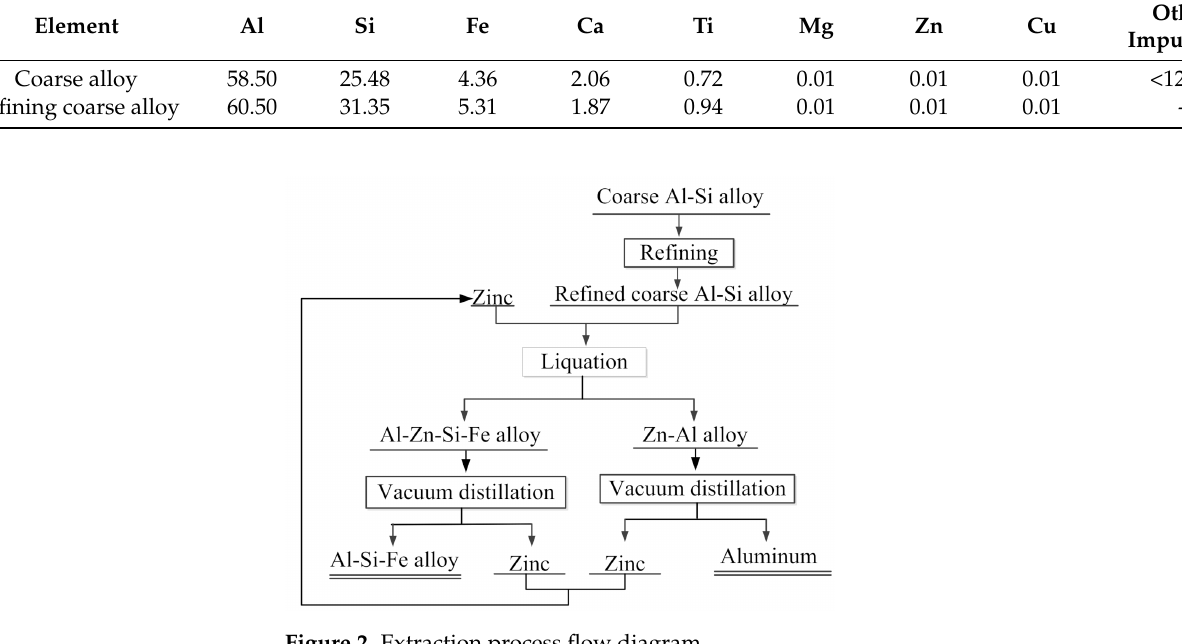
Figure 2. Extraction process flow